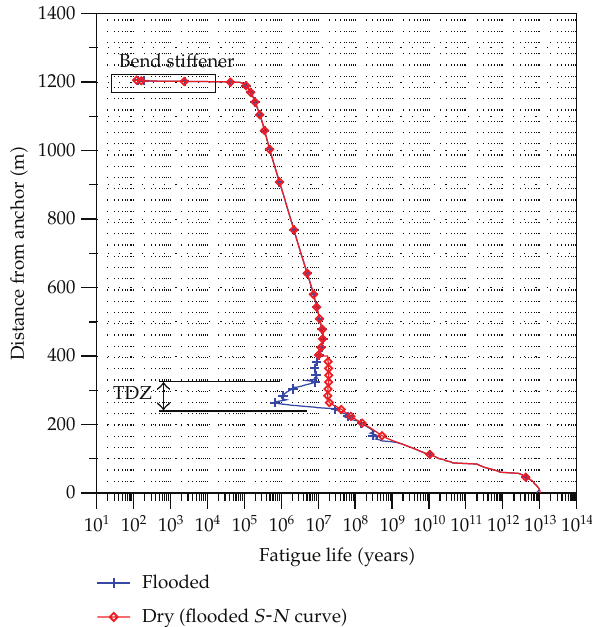
Figure 13: Variation of the fatigue life along the flexible pipe: e ff ect of the annulus conditions (cid:3) dry values are obtained with the flooded S-N curve (cid:4)